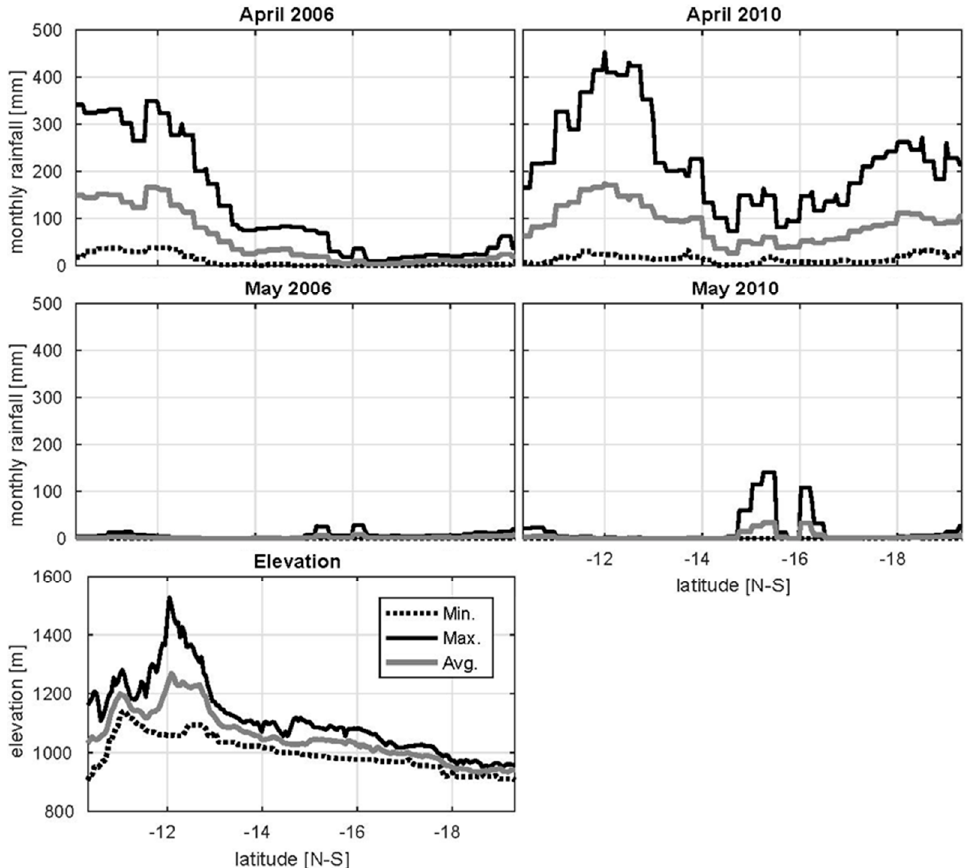
Figure 9. Minimum, maximum, and mean monthly rainfall accumulations along a transect within the UZRB for April and May in a wet year (2006) and a dry (2010) year. The minimum, maximum, and average elevations along the transect positioned between 22.7° and 24° longitude are displayed.